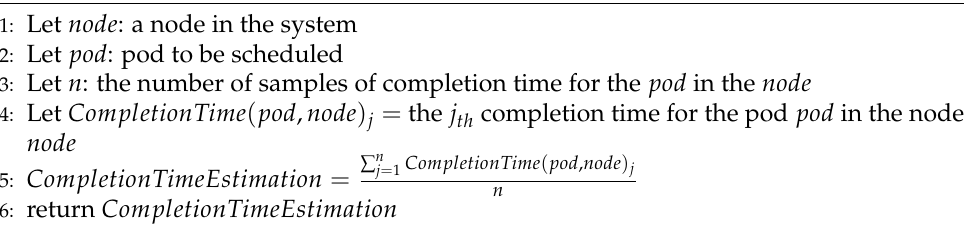
Algorithm 4 CompletionTimeEstimation(pod, node)